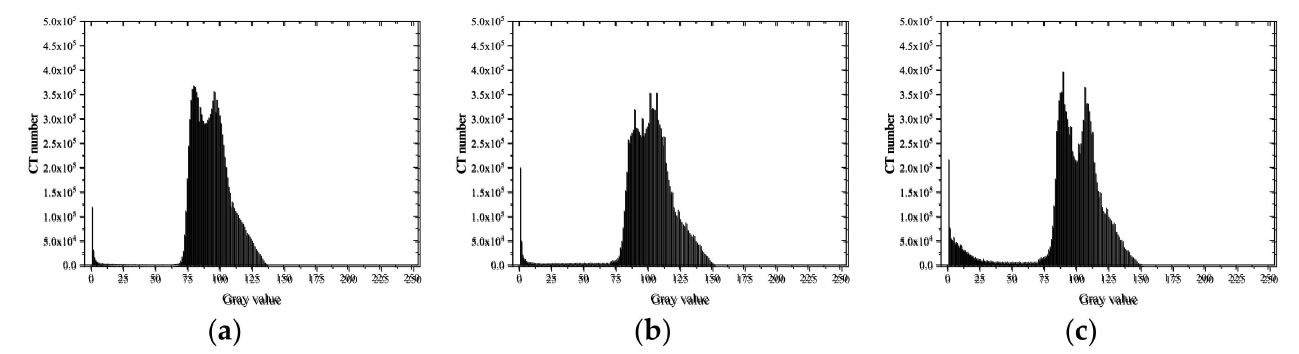
Figure 11. Gray histogram of MA: ( a ) before loading; ( b ) after loading (0.2 mm/min); ( c ) after loading (2 mm/s).